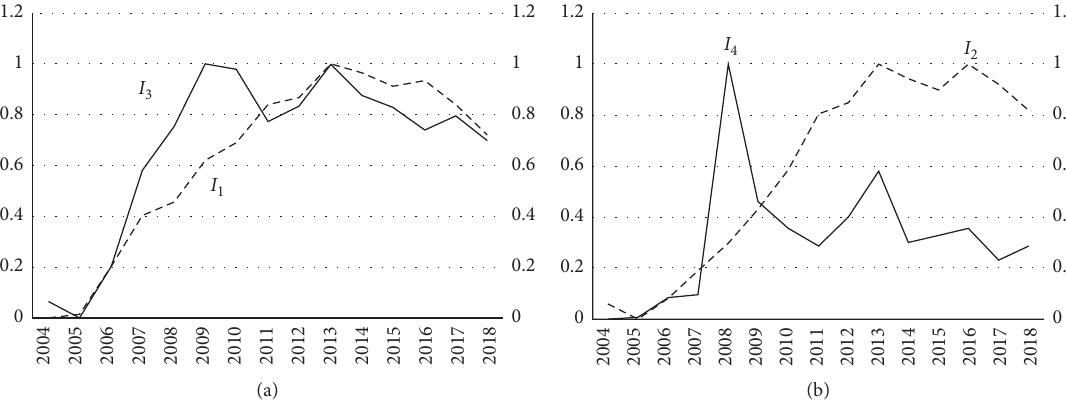
Figure 4: Dynamics of the factors of the state of criminality in the drug trafficking sphere (normalized values, each to its